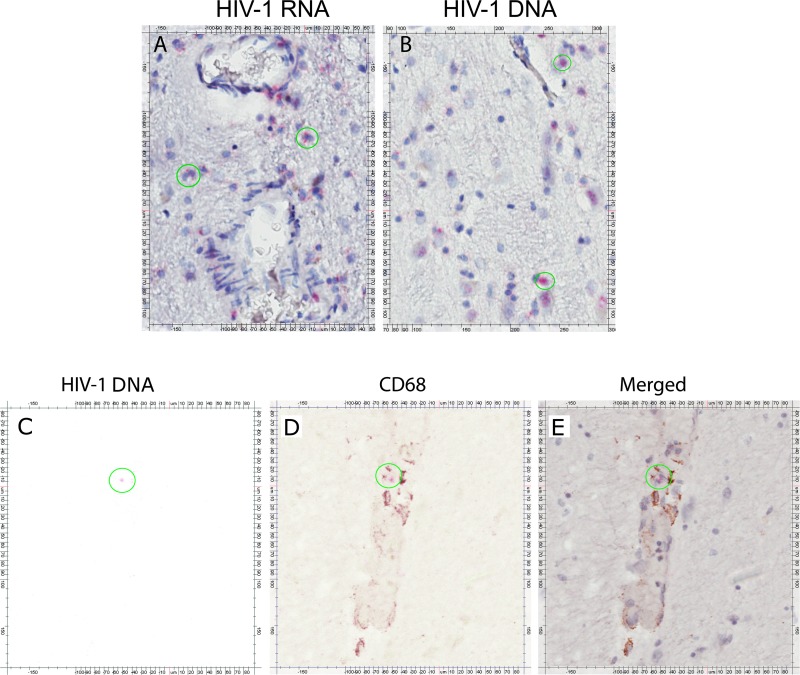
RNA/DNAscope in situ hybridization for HIV-1 RNA and DNA detection.(A) HIV-1 RNA in basal ganglia of subject 319. (B) HIV-1 DNA in basal ganglia of subject 319. (C) HIV-1 DNA in basal ganglia of subject 408. (D) CD68 expression in basal ganglia of subject 408 (E) Merged of HIV-1 DNA and CD68 expression in basal ganglia of subject 408. HIV-1 RNA/DNA positive signals are shown as red color. Nucleus are shown as blue color. CD68 expression are shown as brown color. Green circles highlight representative cells positive for HIV-1 RNA or DNA and/or CD68 expression.